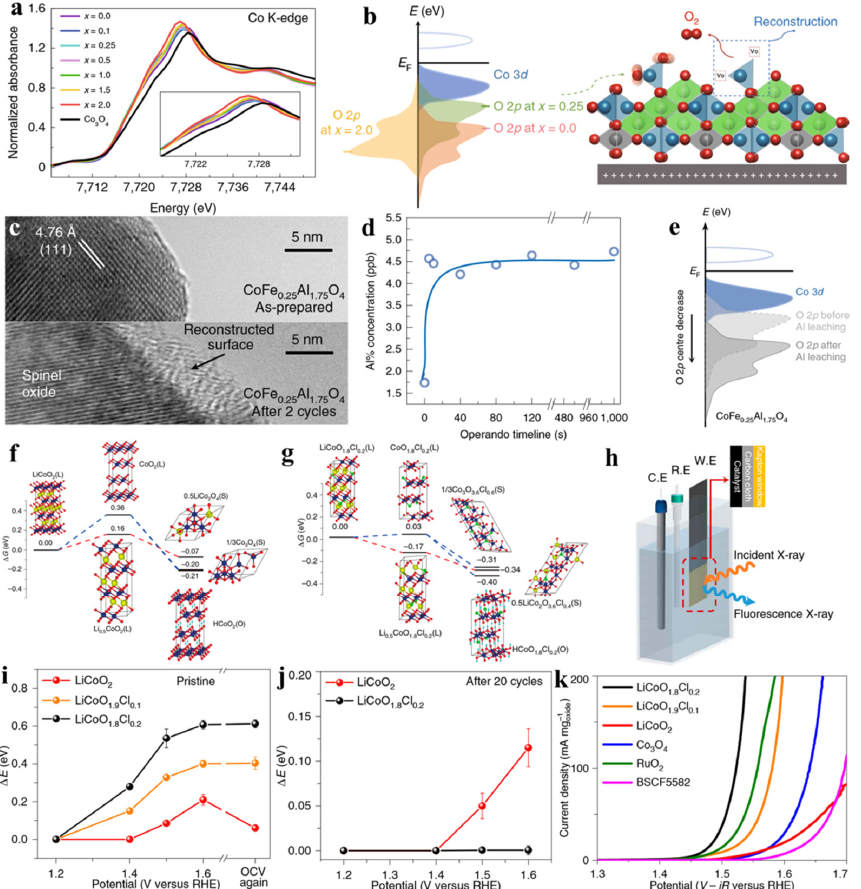
Figure 6. ( a ) Co K -edge XANES spectra of Fe-doped CoAl 2 O 4 samples. ( b ) Schematic band illustra- tions of CoAl 2 O 4 , CoFe 0.25 Al 1.75 O 4 , and CoFe 2 O 4 , and schematic demonstration of the surface recon- struction of CoFe 0.25 Al 1.75 O 4 . ( c ) HRTEM images of the CoFe 0.25 Al 1.75 O 4 catalyst before and after OER tests. ( d ) Al concentration in the reaction electrolyte during the OER process. ( e ) Comparison of the band structure of CoFe 0.25 Al 1.75 O 4 with and without Al 3+ vacancies. Reproduced with permission [104]. Copyright 2019, Nature Publishing Group. Reaction energy profiles at 1.6 V versus RHE for ( f ) LiCoO 2 and ( g ) LiCoO 1.8 Cl 0.2 . ( h ) Experimental set-up scheme for operando testing. ( i ) Co K-edge shift at different potentials for fresh samples. ( j ) Co K-edge shift for cycled samples. ( k ) OER mass activity for LiCoO 2 , LiCoO 1.9 Cl 0.1 , LiCoO 1.8 Cl 0.2 , Co 3 O 4 , BSCF, and RuO 2 . Reproduced with permis-